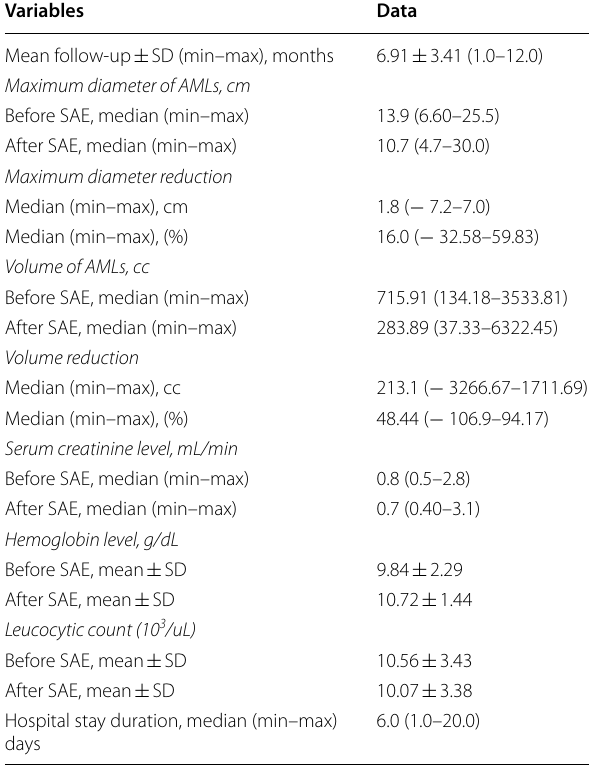
Table 2 Overall success rate